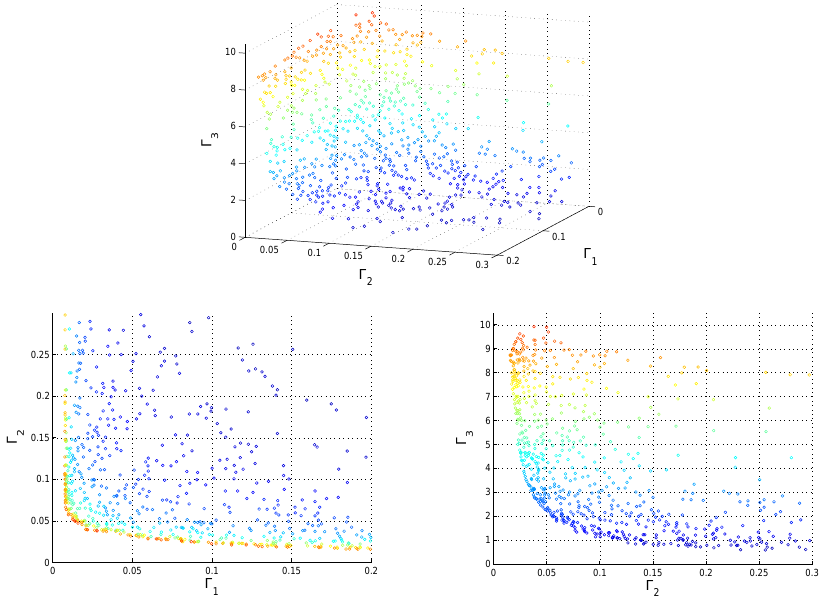
Figure 6. 3D distribution of pareto optimal Γ values ( top ) and projections ( botttom ). Color indicates height (in the Γ 3 direction) and has been added to enhance